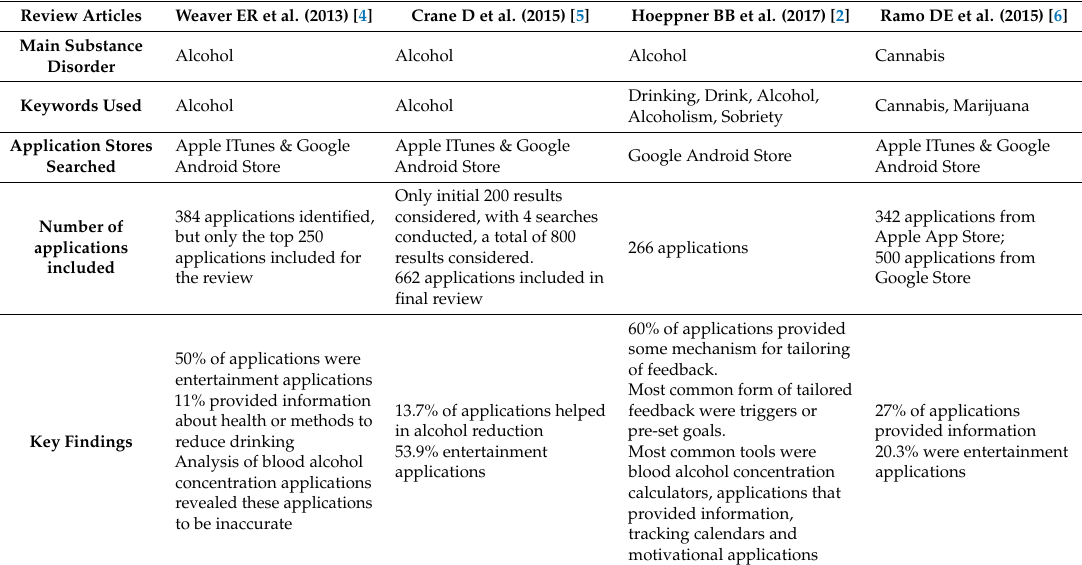
Table 1. Characteristics and Key Findings of each